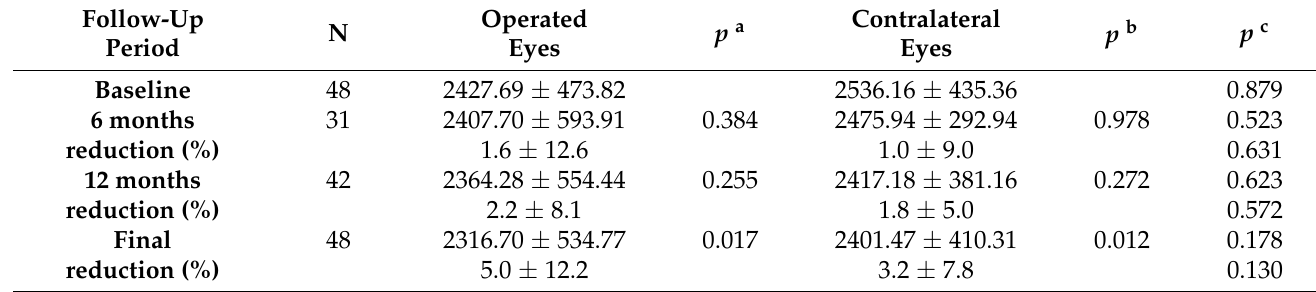
Table 3. Comparison of CECD (cells/mm 2 ) in Ex-PRESS implanted eyes and contralateral